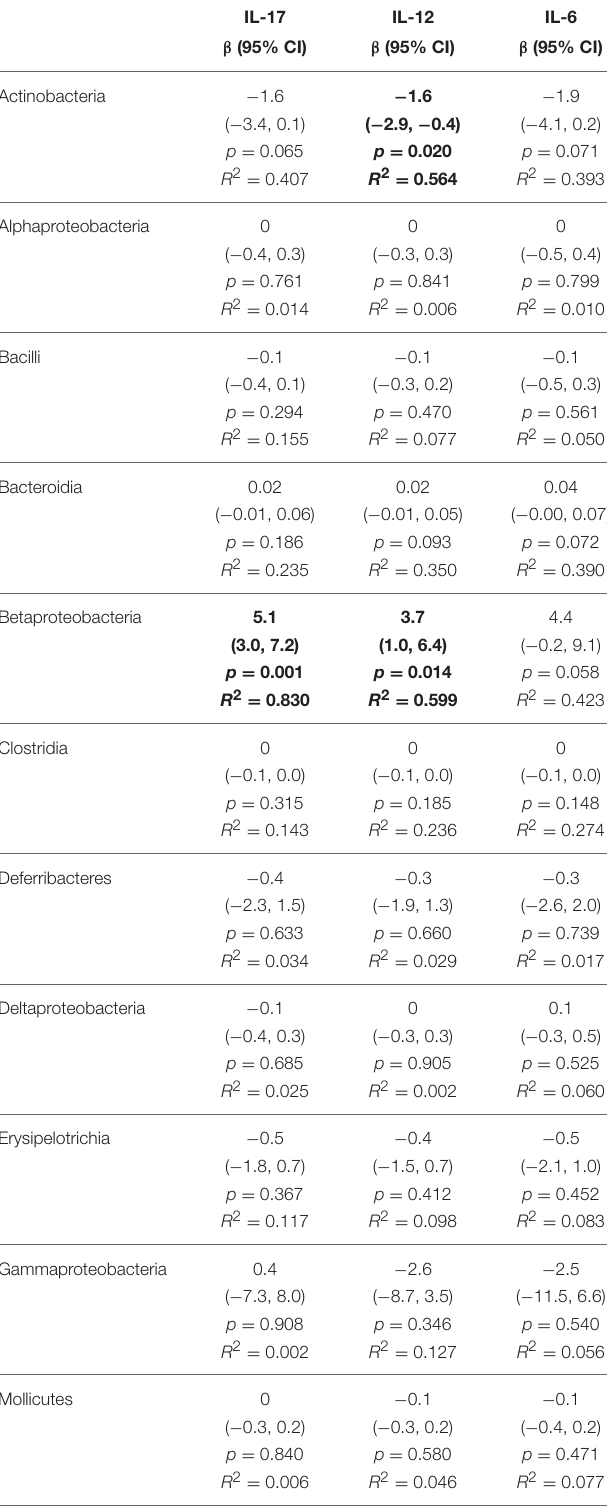
TABLE 3 | Associations from linear regression models between gut microbiota and alterations of adaptive immune system parameters measured in the adipose tissue.